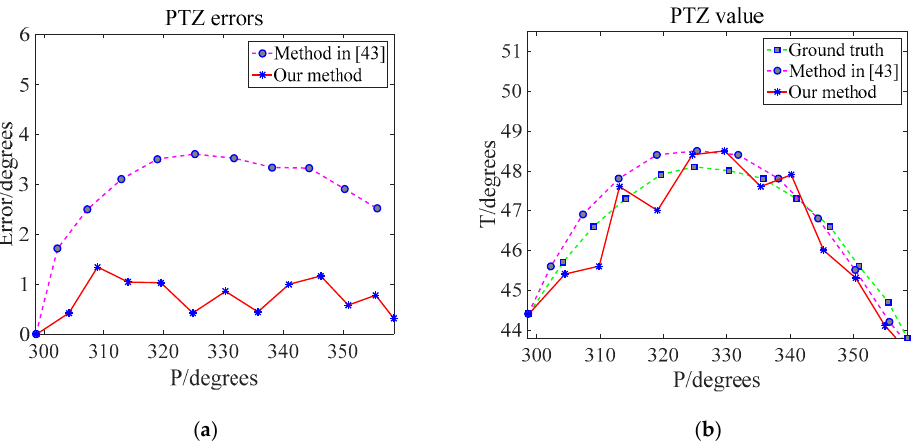
Figure 14. Observation angle and angle error of the PTZ camera in the horizontal channel. ( a ) PTZ value. ( b ) PTZ